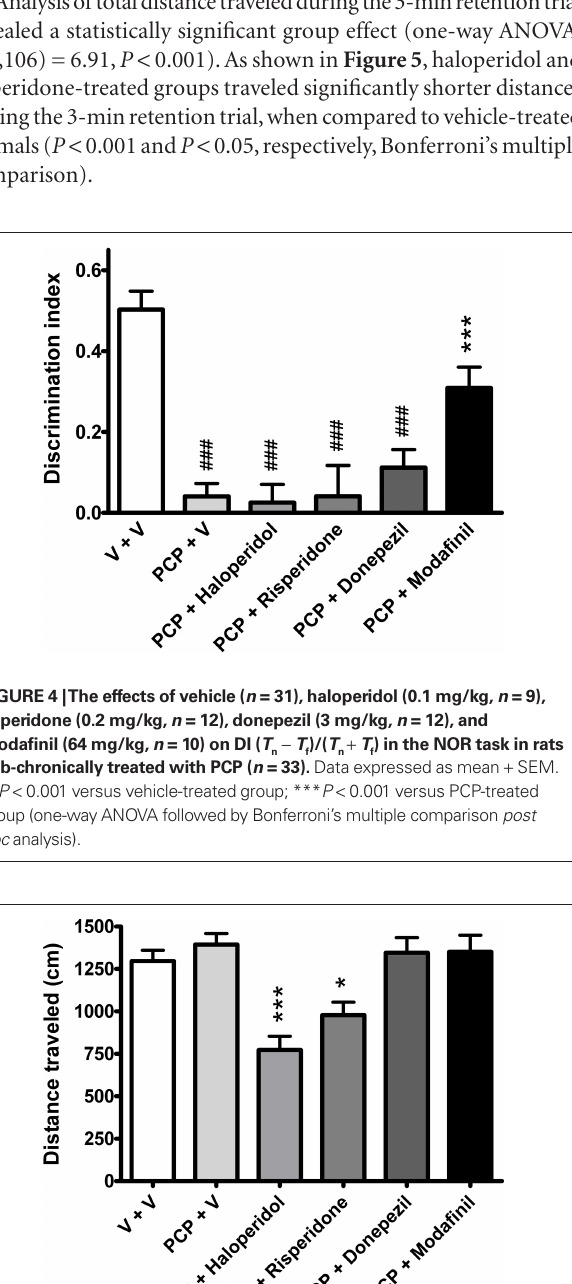
Figure 5 | The effects of vehicle ( n = 31), haloperidol (0.1 mg/kg, n = 9), risperidone (0.2 mg/kg, n = 12), donepezil (3 mg/kg, n = 12), and modafinil (64 mg/kg, n = 10) on distance traveled in the NOr task in rats sub-chronically treated with PCP ( n = 33). Data expressed as mean + SEM. *** P < 0.001, * P < 0.05 versus vehicle-treated group (one-way ANOVA followed by Bonferroni’s multiple comparison post hoc